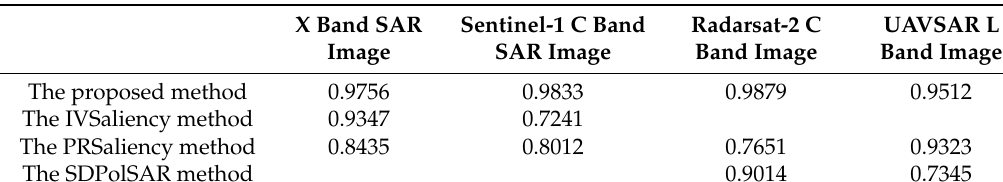
Table 1. Area under the curve (AUC) results of different methods.